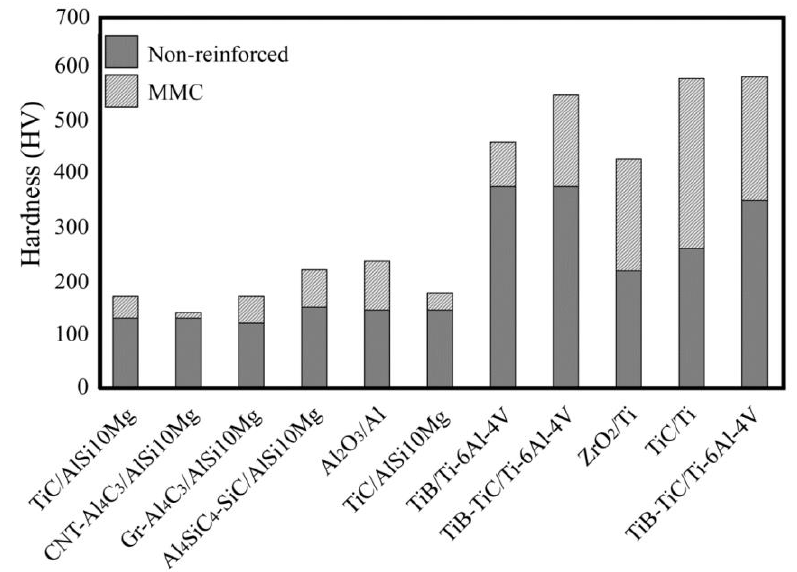
Figure 12. A comparison between the hardness of SLM-processed AMCs/TMCs and their monolithic non-reinforced counterparts in TiC/AlSi10Mg [53], CNT-Al 4 C 3 /AlSi10Mg [70], Gr-Al 4 C 3 /AlSi10Mg [73], Al 4 SiC 4 -SiC/AlSi10Mg [74], Al 2 O 3 /Al [105], TiC/AlSi10Mg [106], TiB/Ti-6Al-4V [79], TiB-TiC/ Ti-6Al-4V [79], ZrO 2 /Ti [80], TiC/Ti [107] and TiB-TiC/Ti-6Al-4V [51] systems. Microhardness measurements have been conducted on coupons with the same shape but different sizes.